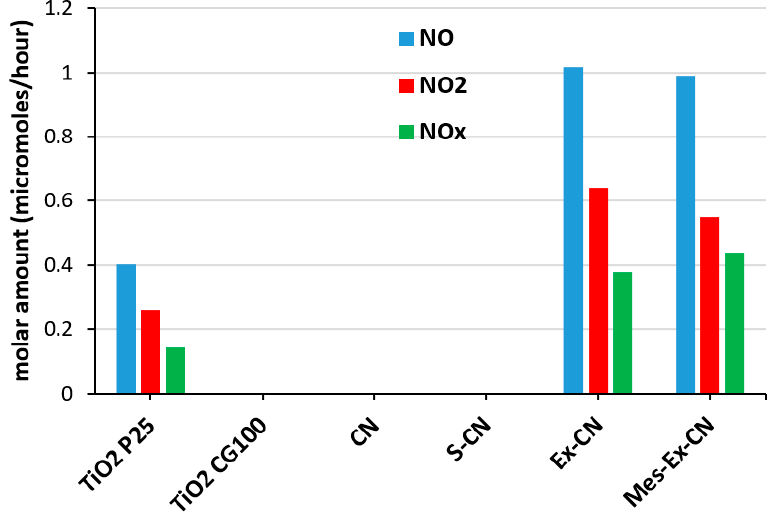
Figure 8. Amount of removed NO, NO x and formed NO 2 , respectively, under VIS fluorescent irradiation during a 1 h NO x experiment.